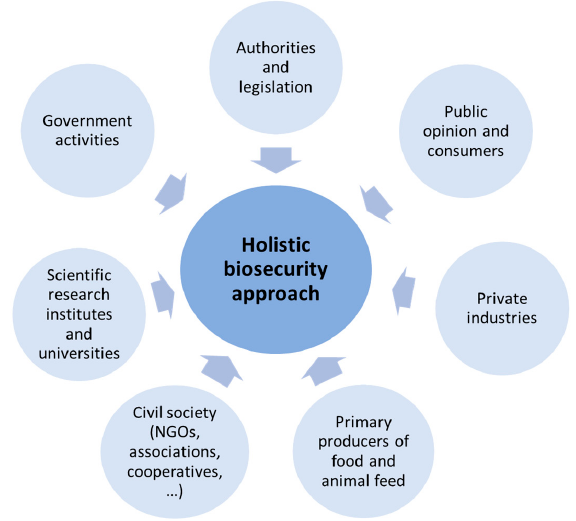
Figure 2. Sector interests that are important to a holistic approach of biosecurity (Adapted from the FAO, 2007 [18]). Table 1. Examples of different types of hazards applicable to different biosecurity sectors (Adapted from FAO, 2007 [18]).